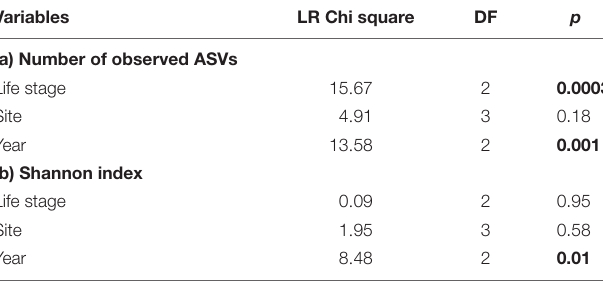
TABLE 1 | Summary of the GLM predicting (a) Number of observed ASVs, (b) Shannon index, according to life stage, study site, and year. Variables